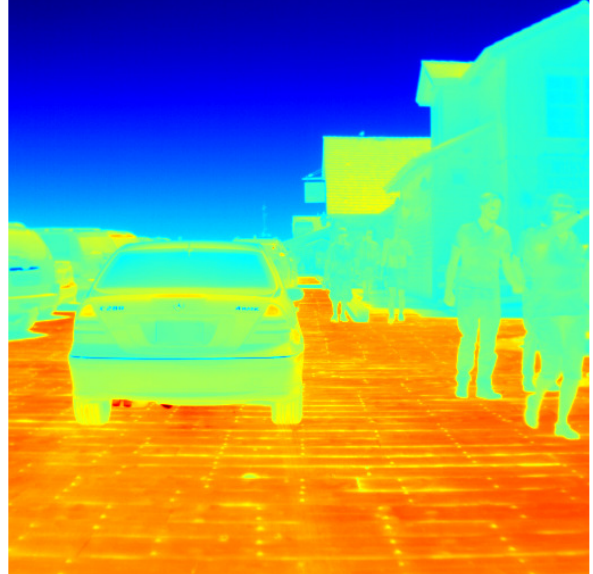
Figure 1. False colour thermal image at original resolution The pseudo-multispectral (PS-MS) image is the one composed of the three RGB bands of the false-colour thermal image (fig- ure 1) together with the image corresponding to the raw thermal values in grey scale (figure 2). To clarify, PS-MS is a multis- pectral image with 4